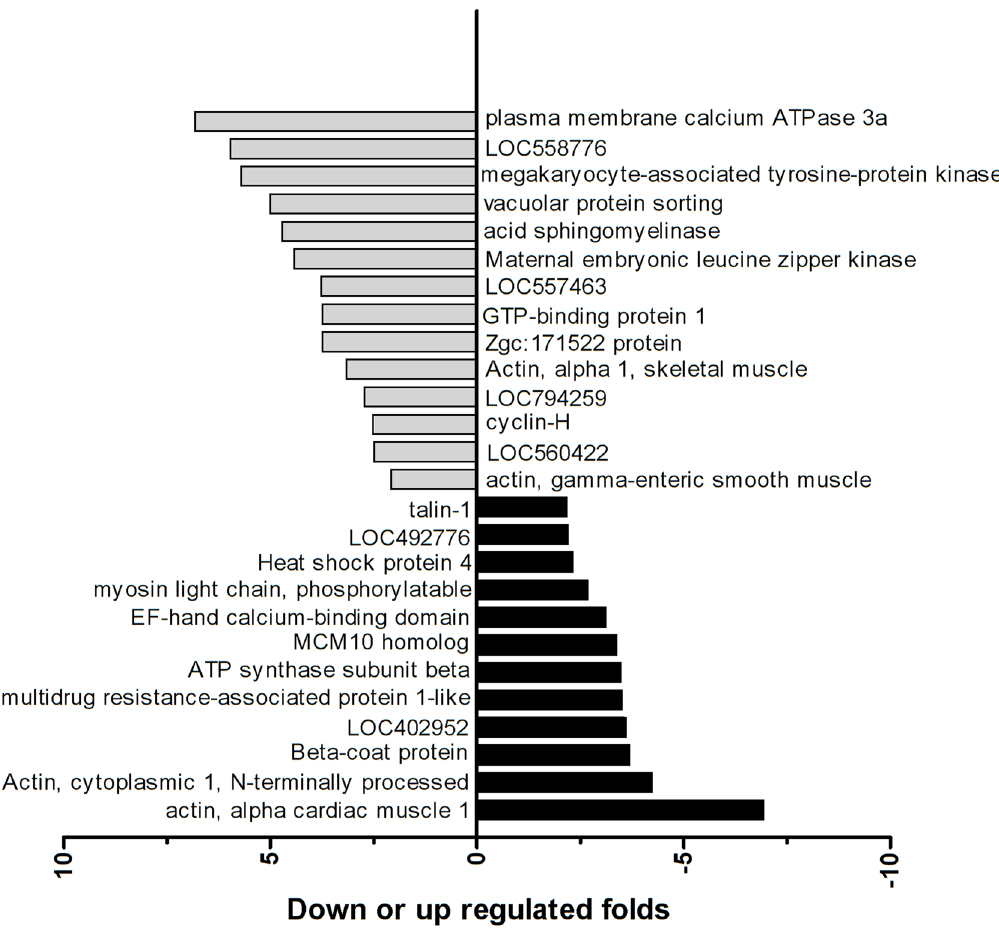
Figure 2. The differential protein spots between the DKA treatments and control groups. Note: The differential protein spots had . 2.0- fold changes in the DKA treatment groups compared to the control group.